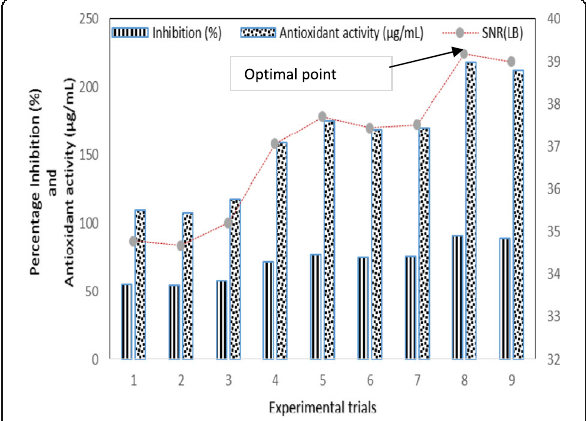
Fig. 1 The graphical illustration of inhibition percent, antioxidant activity, and SNR for each experimental runs